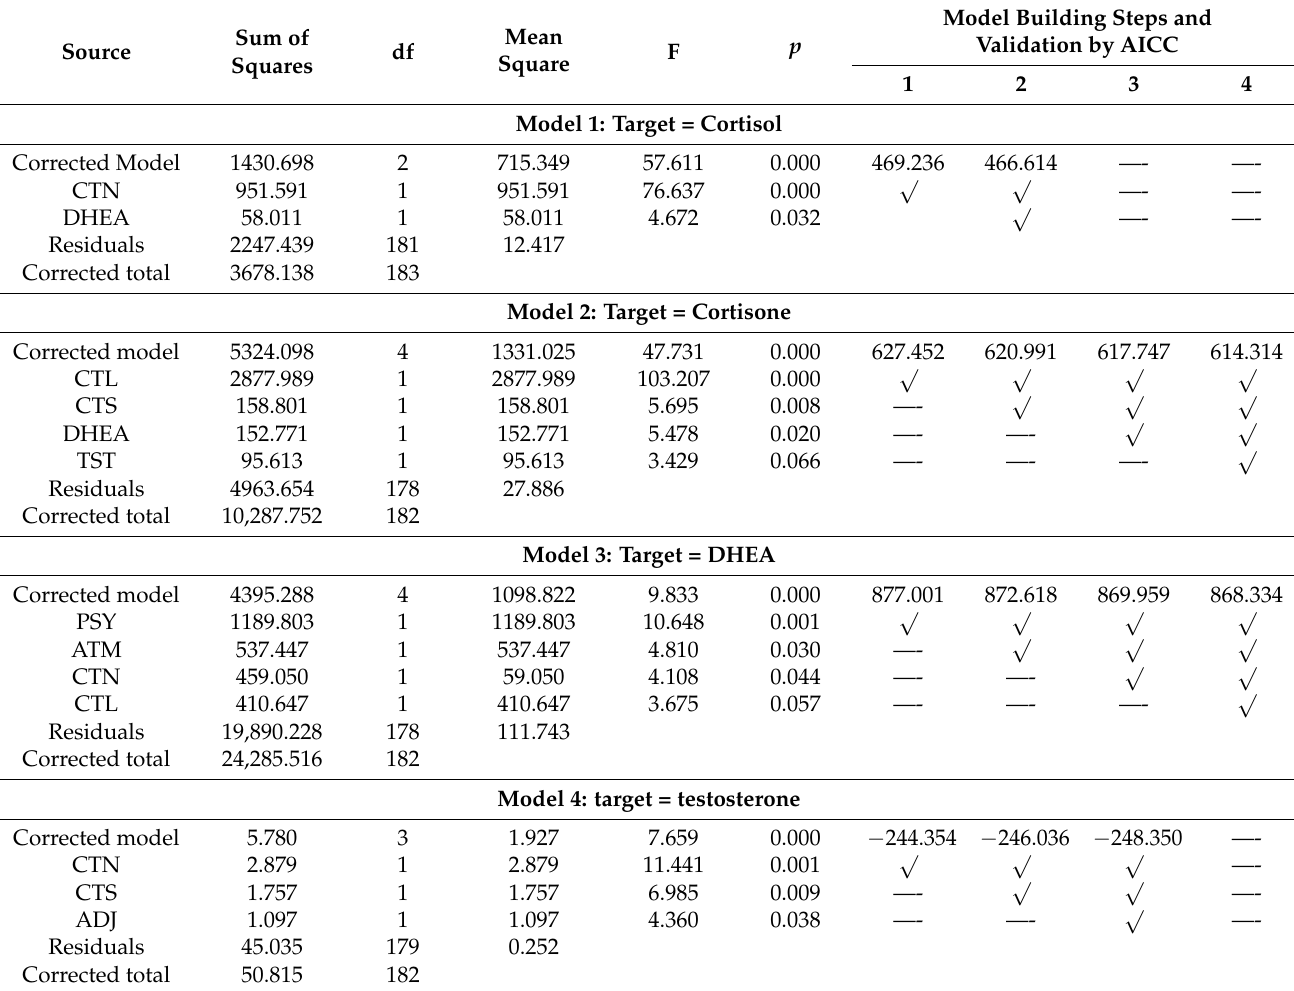
Table 5. Forward stepwise model effects and validation by AICC